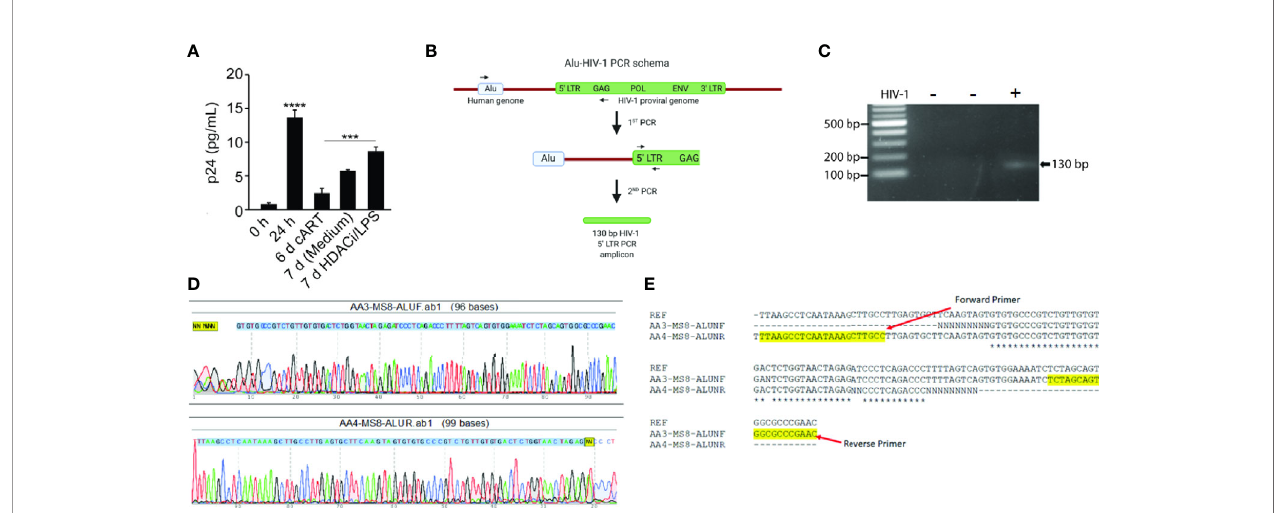
FIGURE 3 | Differentiated NHBE cells act as HIV-1 reservoir and Alu-PCR analysis con fi rming the integration of HIV-1 proviral genome in NHBEs. (A) HIV-1 p24 levels after latency-reversing agents, vorinostat and LPS, treatment of HIV-1 infected cells. (B) Schematics of the nested-PCR approach used to con fi rm the HIV DNA integration in infected NHBEs. (C) Agarose gel analysis of the nested PCR amplicon showing ampli fi cation of 130 bp band from 5 ′ LTR region of HIV-1. (D) Electropherogram of the 130 bp PCR amplicon generated using Forward and Reverse primers con fi rms the presence of the HIV proviral genome (The 5 ′ -LTR sequence of HIV is indicated with blue shade). (E) Multiple sequence alignment of edited HIV-1 5 ′ -LTR sequence obtained from the sequencing of the 130 bp PCR amplicon along with the sequence of HIV-1 LAV used to infect the NHBEs. The primer sequences used are highlighted in yellow. Data shown as mean ± SEM; n = 3/ group; ***p < 0.001; ****p <